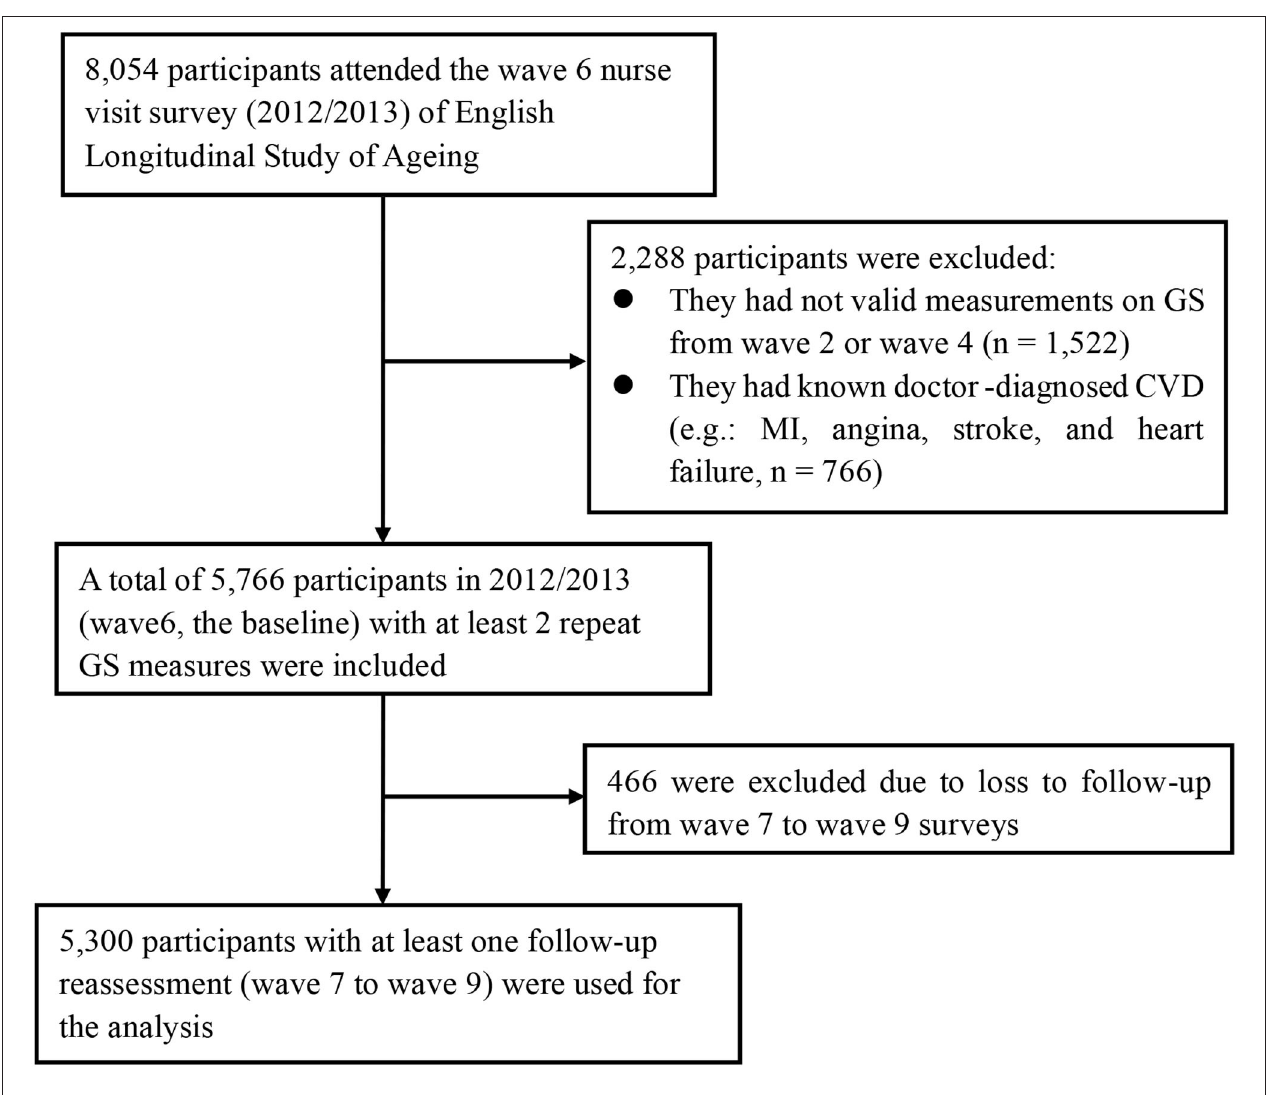
FIGURE 1 | Flowchart of participant selection for the present study population. CVD, cardiovascular disease; MI, myocardial infarction; GS, grip